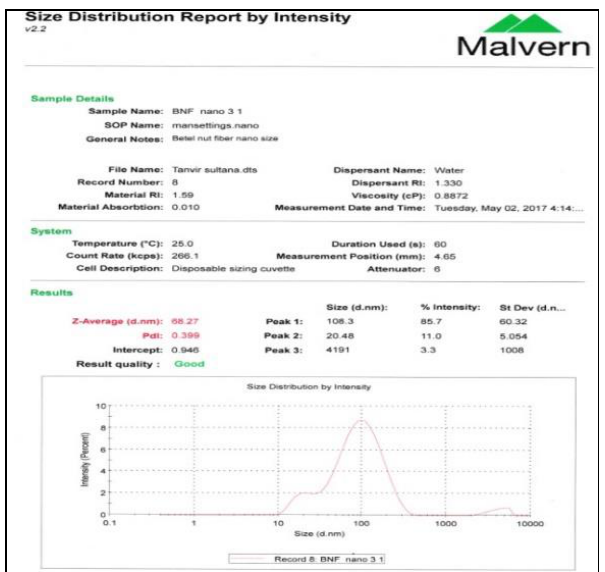
Figure A4. Zeta Potential Reports (sonicated nano cellulose).